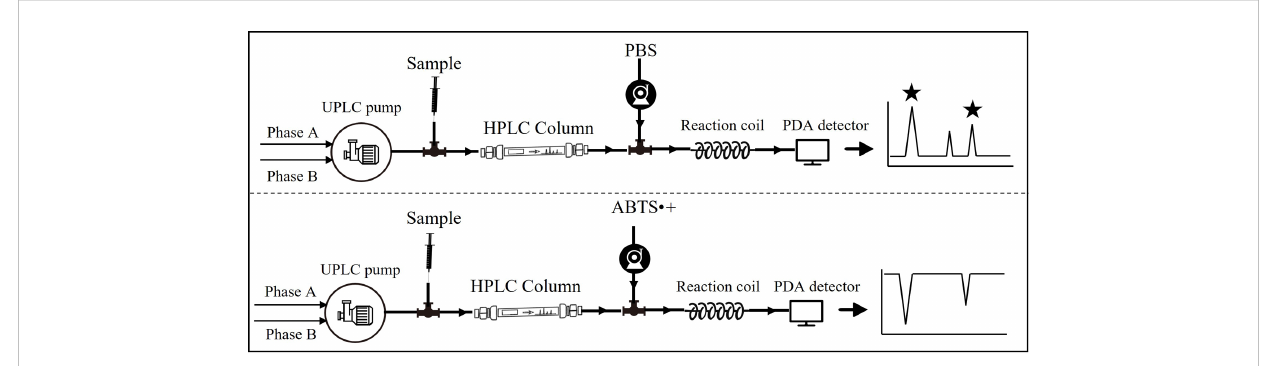
FIGURE 1 Flow chart of online detection of